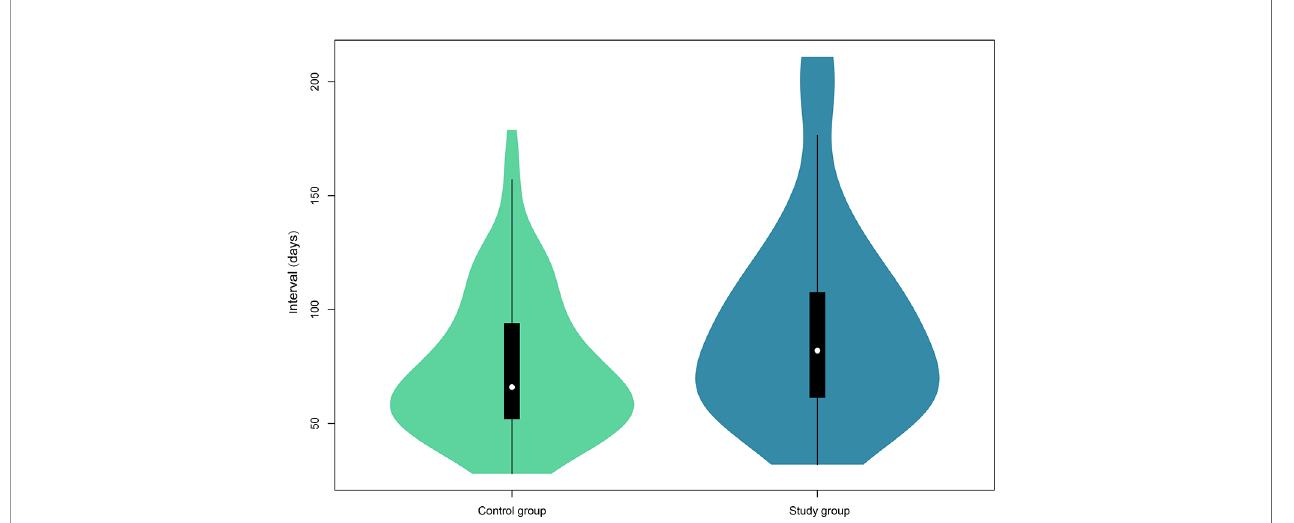
FIGURE 1 | Violin plots of the follow-up interval of the two groups. The white dot indicates the median of the interval, whereas the black box presents the interquartile range. The thin black line shows 95% con fi dence interval. The width of the violin represents frequencies of interval values.